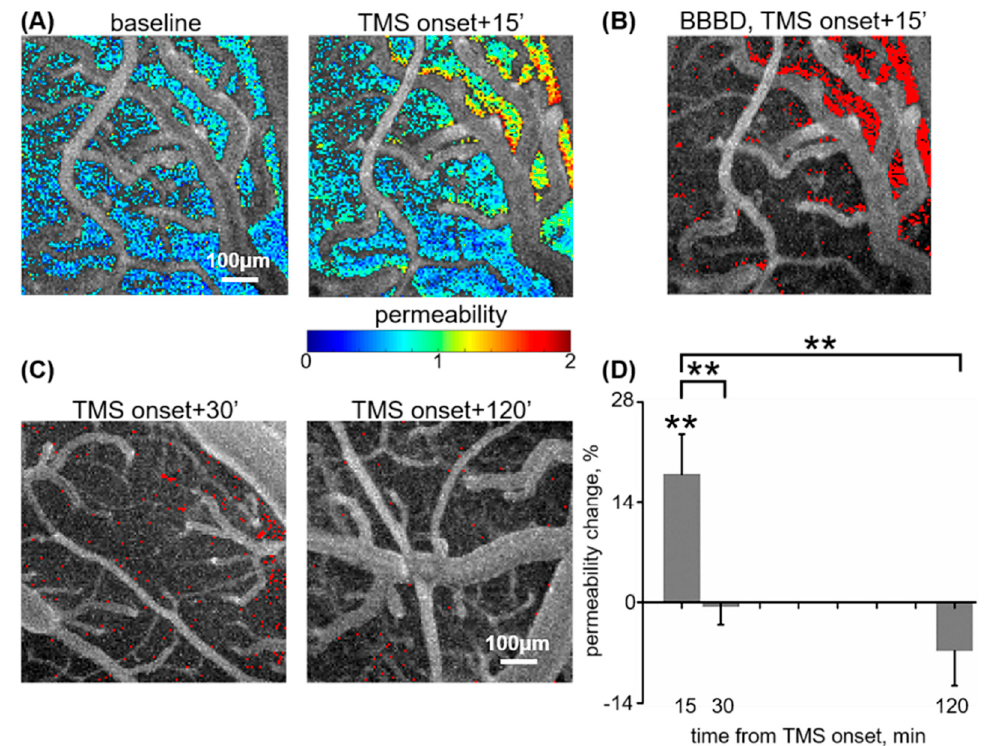
Figure 1. Low-frequency repetitive transcranial magnetic stimulation (rTMS)-induces blood–brain barrier (BBB) opening is time-dependent. ( A ). Fluorescent angiography of the right, exposed motor cortex of the rat, overlaid with extravascular permeability index (see Section 2), at baseline (left) and 15 min from low-frequency rTMS onset (right). ( B ) . Detection of BBB dysfunction (BBBD). Fluorescent angiography, at 15 min from TMS onset, overlaid with detection of extravascular pixels (red) in which permeability has changed from baseline in > 3 standard deviations of the mean change seen following sham stimulation [27]. Magnification is identical to ( A ). ( C ) . Similar analysis as in B, performed for 30 min (left) and 120 min (right) from TMS onset. ( D ) . Mean ± squared error of the mean (SEM) change in permeability index relative to baseline for 15 [27], 30, and 120 min from TMS onset. ** p < 0.01.